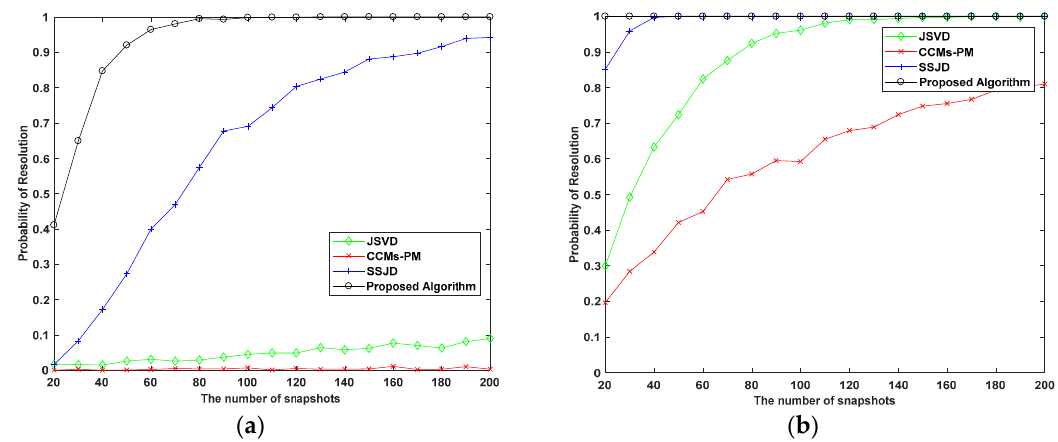
Figure 9. Probability of Resolution versus snapshots ( a ) SNR = 0 dB; ( b ) SNR = 10 dB.